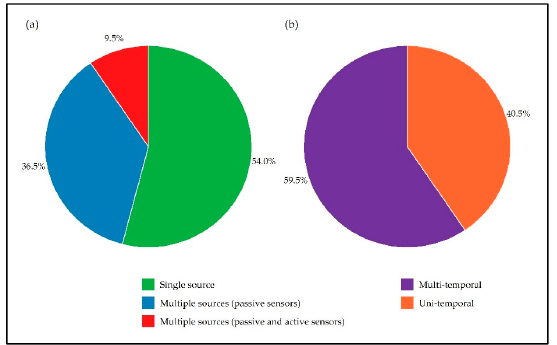
Figure 4. Distribution of documents based ( a ) types of sensors and ( b ) temporal scale analysed.